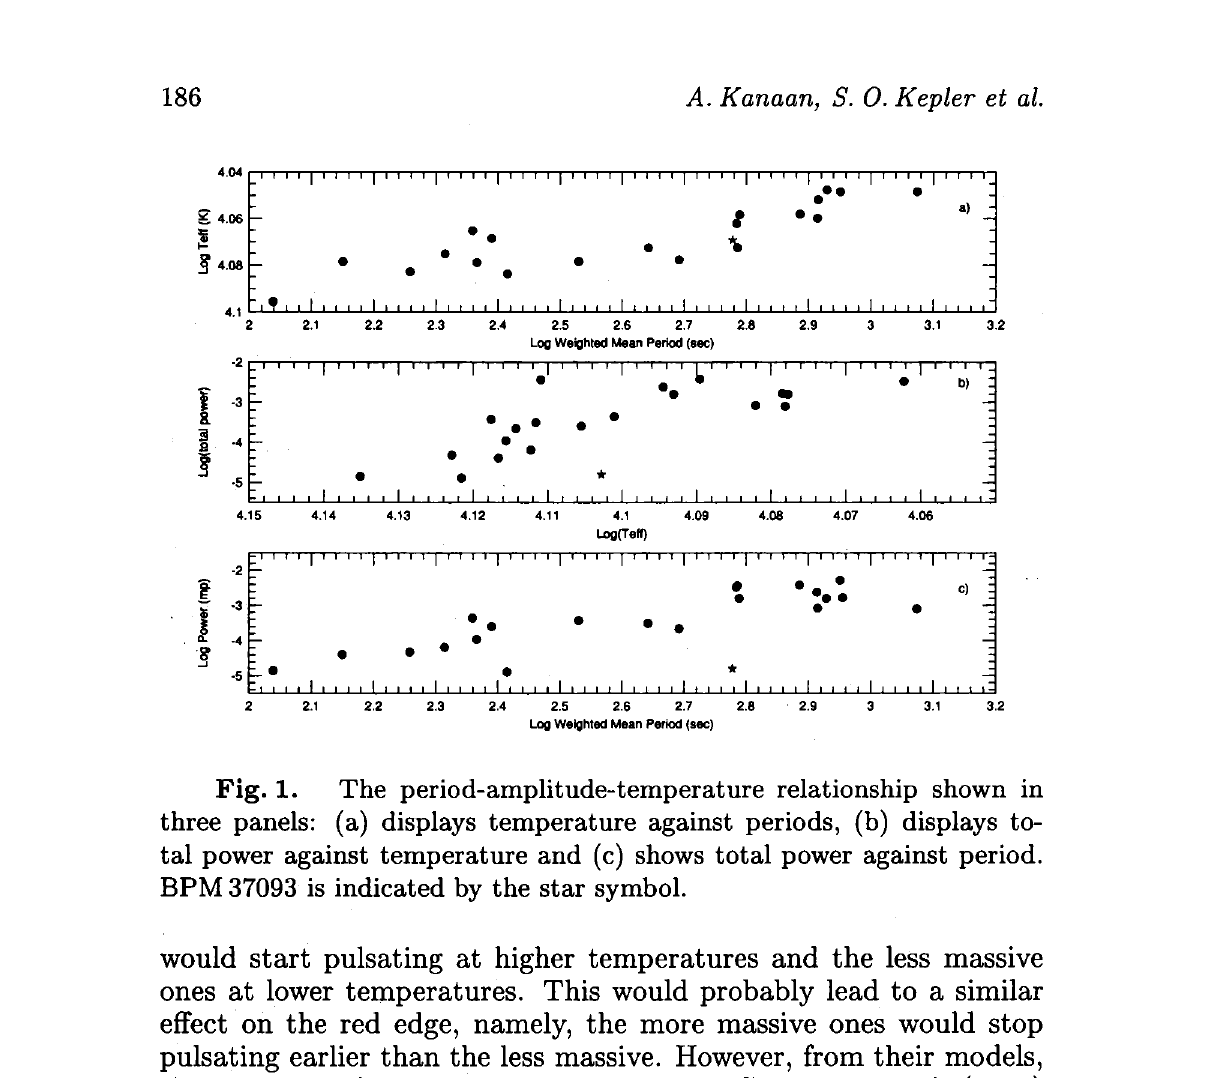
Fig. 1. The period-amplitude-temperature relationship shown in three panels: (a) displays temperature against periods, (b) displays to- tal power against temperature and (c) shows total power against period. BPM 37093 is indicated by the star